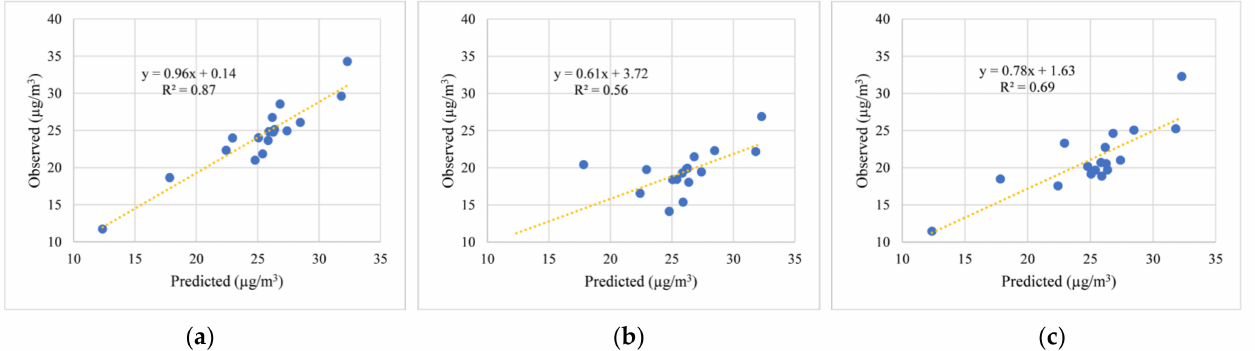
Figure 13. The relationship between the observation and the predictors is evaluated through re- gression analysis in 2018. ( a ) Observation regressed against predictors with integration between geographic and remote sensing datasets. ( b ) Observation regressed against predictors with a remote sensing dataset. ( c ) Observation regressed against predictors with a geographic